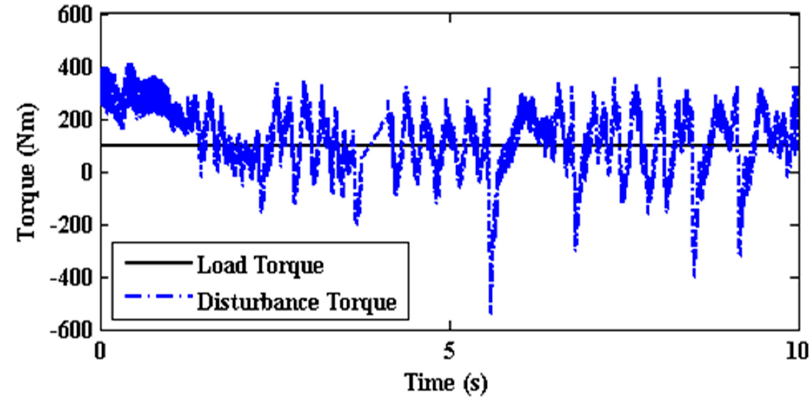
Figure 7. Estimated disturbance torque of SMLO 1. Energies 2017 , 10 , 1077